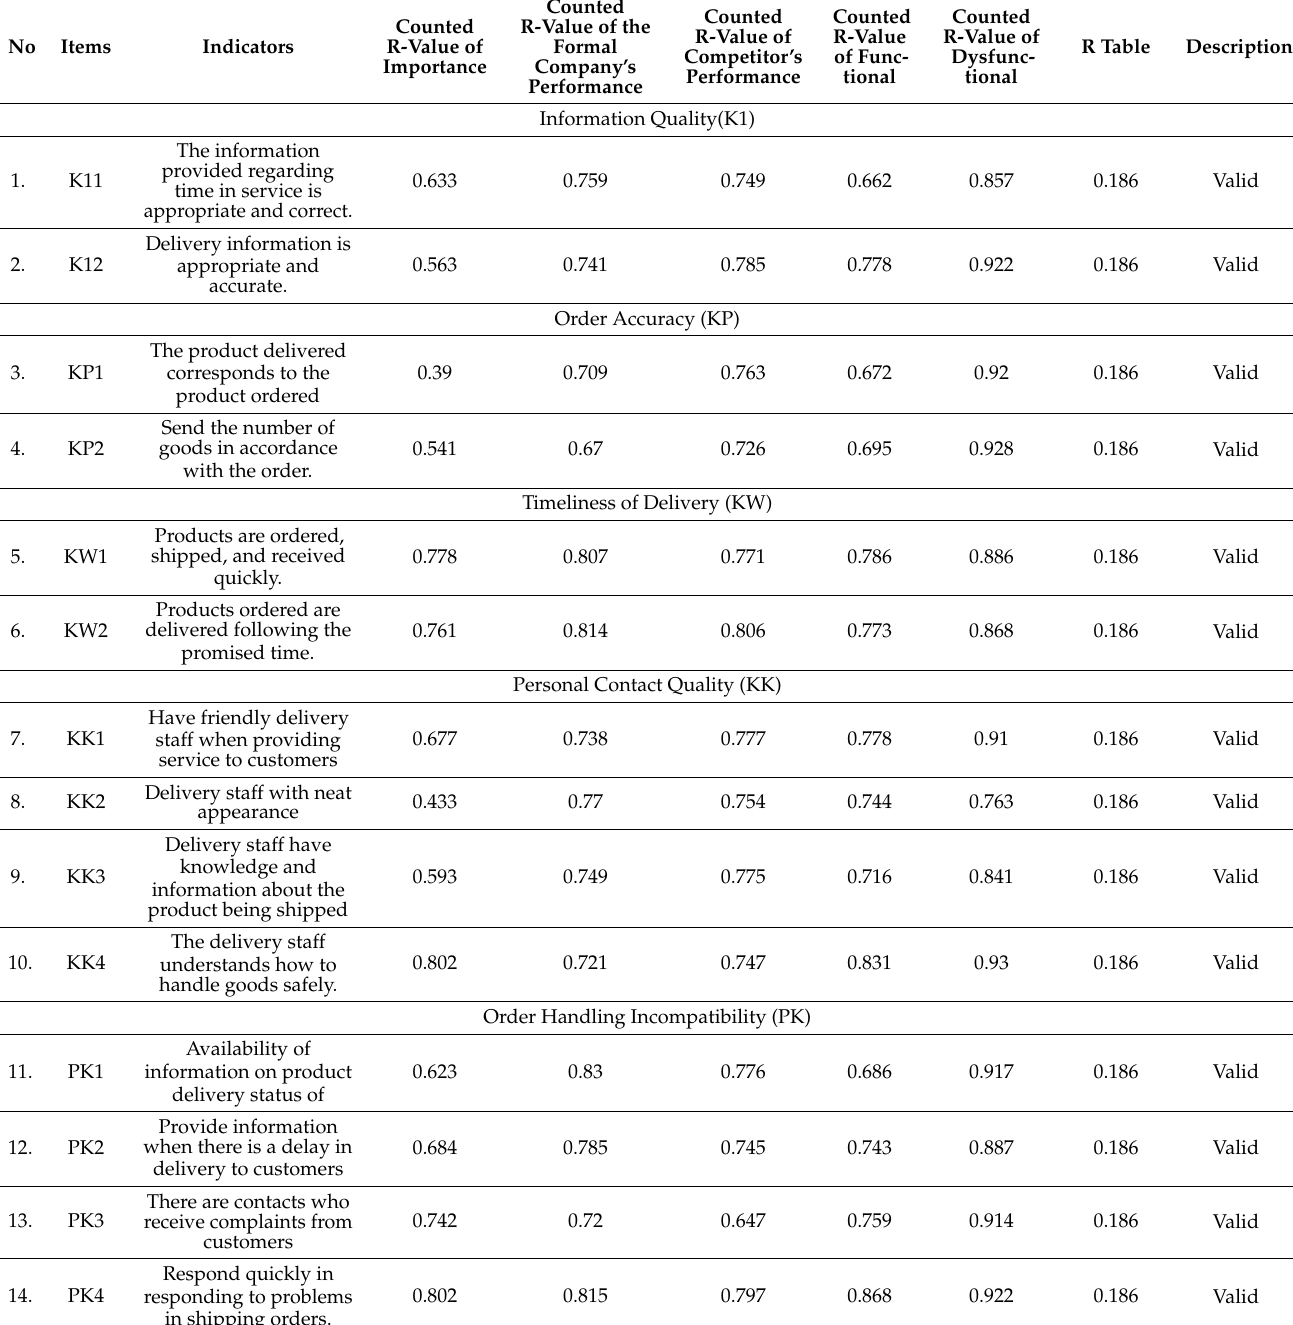
Table 6. Validity test results of formal questionnaire SIPA Modified-Kano.